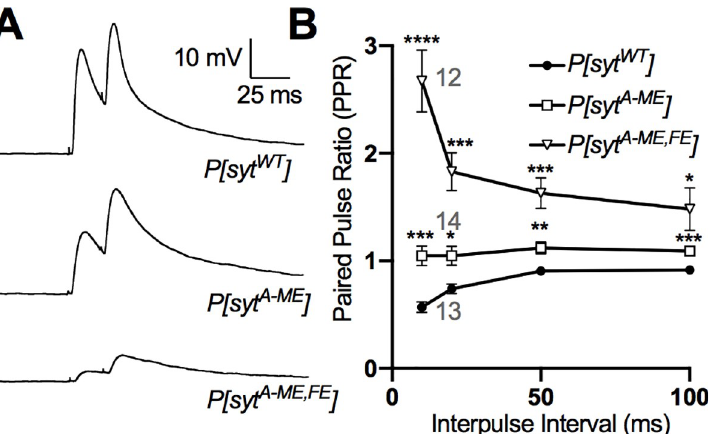
Fig 5. Probability of release is decreased by hydrophobic mutations. Probability of release was determined using a paired pulse protocol with interpulse intervals of 10, 20, 50, and 100ms. A, Representative traces of paired EJPs for P [syt WT ] , P[syt A-ME ] , and P[syt A-ME , FE ] with a 20ms interpulse interval. B, Mean paired pulse ratios ± SEM for P[syt WT ] , P[syt A-ME ] , and P[syt A-ME , FE ] (Two-way Repeated Measures ANOVA with Tukey post-hoc, p < 0.05 = � , p < 0.01 = �� , p < 0.001 = ��� , p < 0.0001 = ���� ). Indicated differences are between mutants and P[syt WT ] , though the paired pulse ratio was significantly different (p < 0.05) between P[syt A-ME ] , and P[syt A-ME , FE ] , for all interpulse intervals except